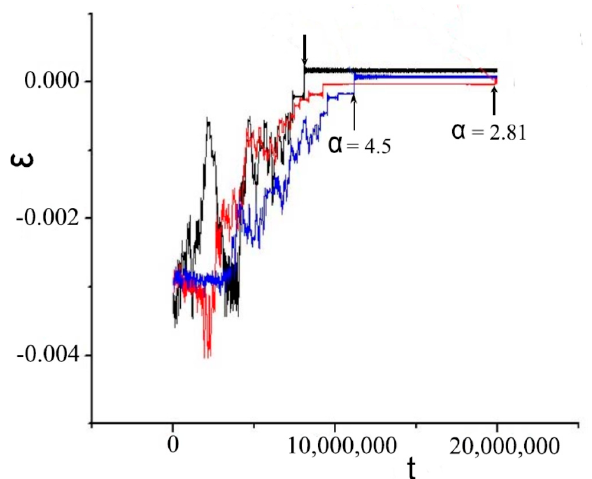
Figure 13. Temporal evolution of binding energy ε of the 13P-state ( l = 1) of the Rydberg electron in the Sommerfeld atom in an external microwave field of frequency ω = 1/13 3 and amplitude E 0 = 10 E c , which exceeds ten times the critical value E c . The calculations were performed for three values of Sommerfeld parameter: α = 0, 2.81, and 4.5. The arrows indicate the moments of ionization. The occurrence of Förster resonance corresponds to α p , s = 2.81.